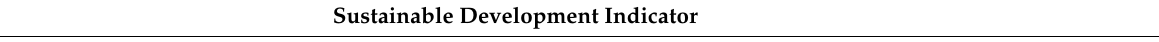
Table 1. Sustainable Development Indicators used in the